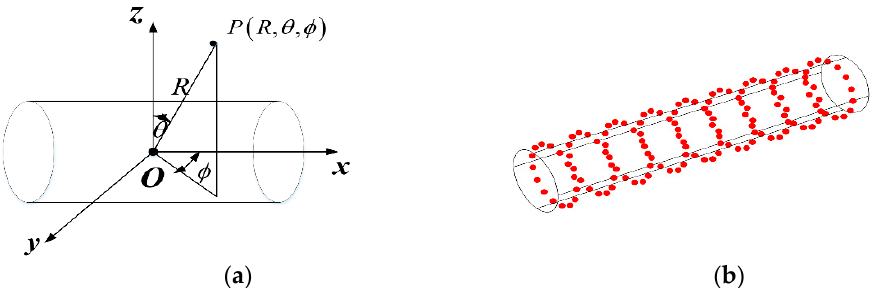
Figure 4. ( a ) The coordinate system for the structure; ( b ) the measurement points on the structural surface.